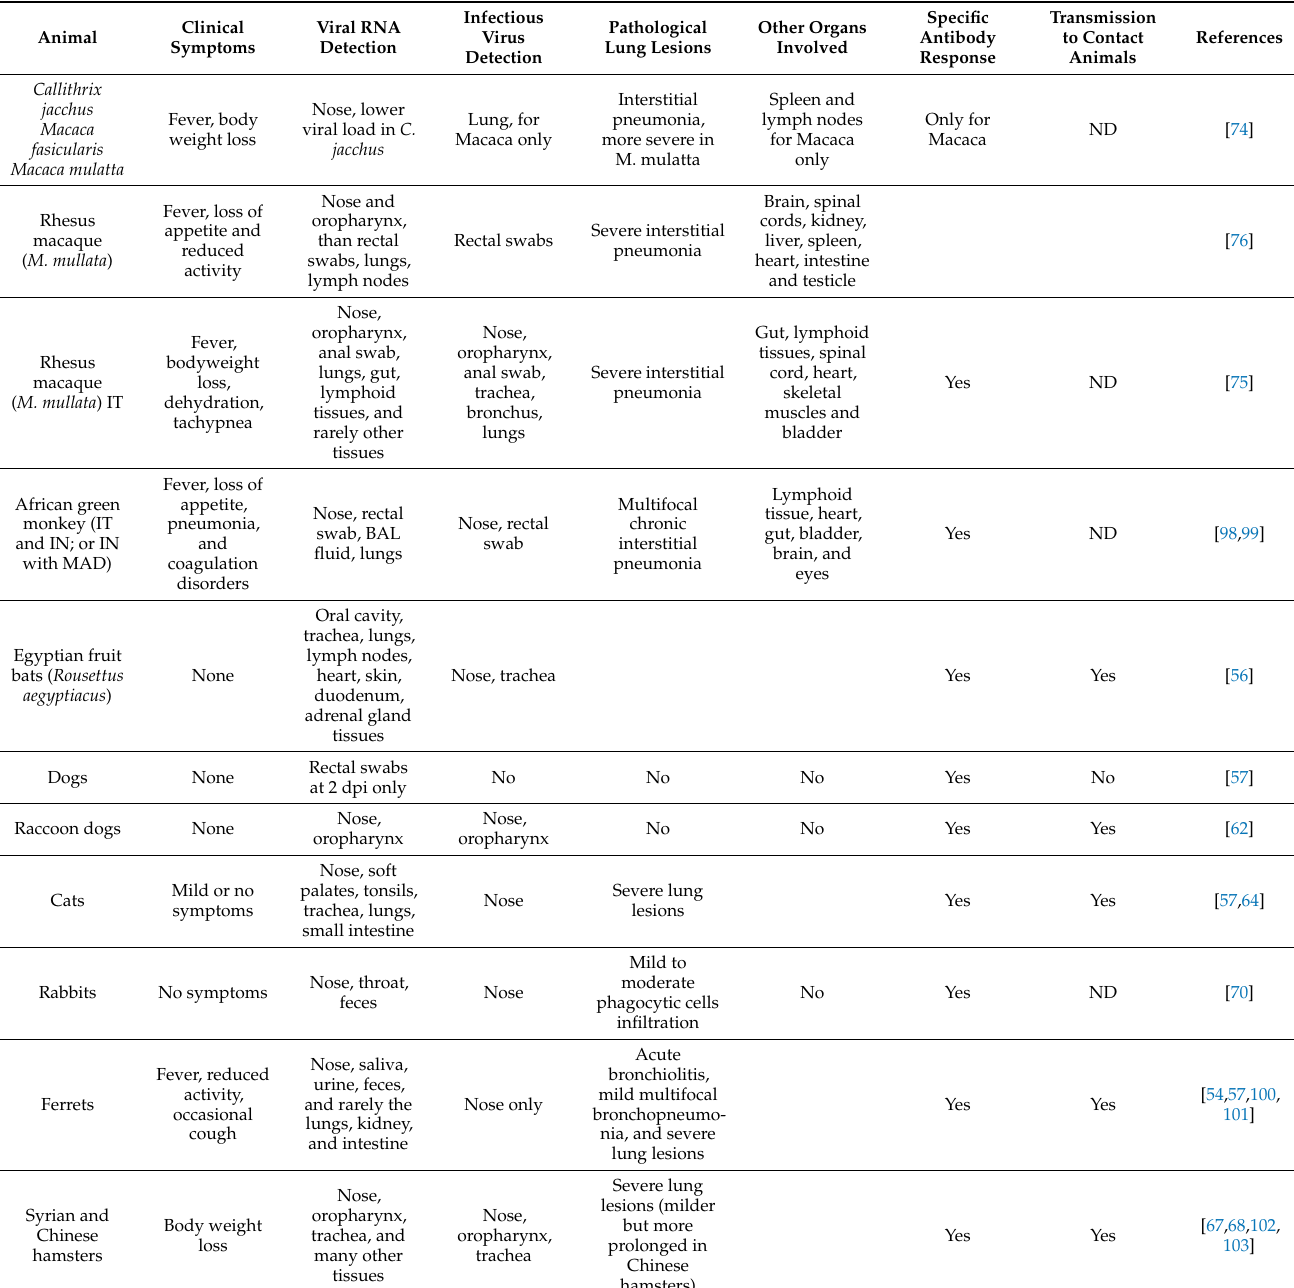
Table 2. Experimental models of SARS-CoV-2 infection. The route of infection was intranasal, unless otherwise specified.